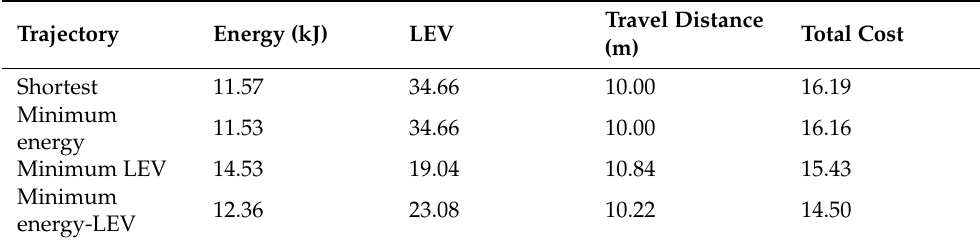
Table 6. Simulation results in case